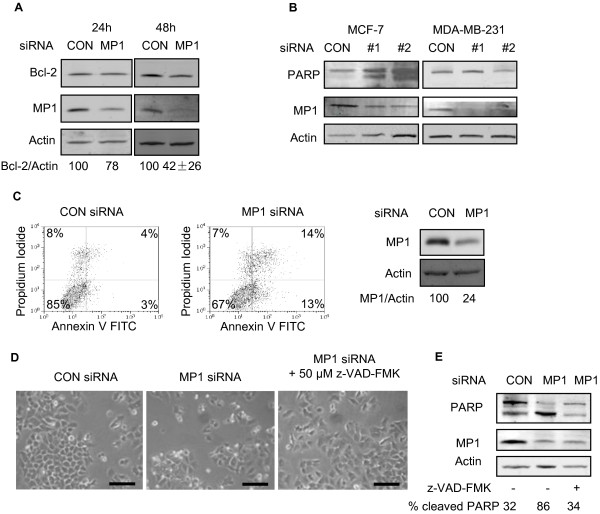
MP1 silencing induces apoptosis of MCF-7 but not of MDA-MB-231 cells. MCF-7 or MDA-MB-231 cells were transfected for 24 or 48 h with 30 nM control or MP1 siRNA. (A) Immunoblot of Bcl-2 protein levels in extracts of MCF-7 cells. Numbers represent the Bcl-2/Actin ratios expressed as percentage of control samples for a single experiment (24 h)or the average ± SD of 3 independent experiments (48 h, p < 0.05). (B) Immunoblot of PARP in extracts of MCF-7 and MDA-MB-231 cells at 48 h. (C) Transfected MCF-7 cells were harvested at 48 h, stained with Annexin V and propidium iodide, and analyzed by flow cytometry as described in the methods section. Numbers in the 4 quadrants represent the percentage of cells that are PI-/Annexin- (lower left), PI+/Annexin- (upper left), PI-/Annexin+ (lower right) and PI+/Annexin+ (upper right). The immunoblot of MP1 expression is also shown. (D) Photographs of MCF-7 cells transfected with MP1 siRNA in the absence or presence of 50 μM z-VAD-FMK at 48 h. Scale bar = 100 μm. (E) Immunoblot and quantification of PARP cleavage at 48 h under the indicated conditions.